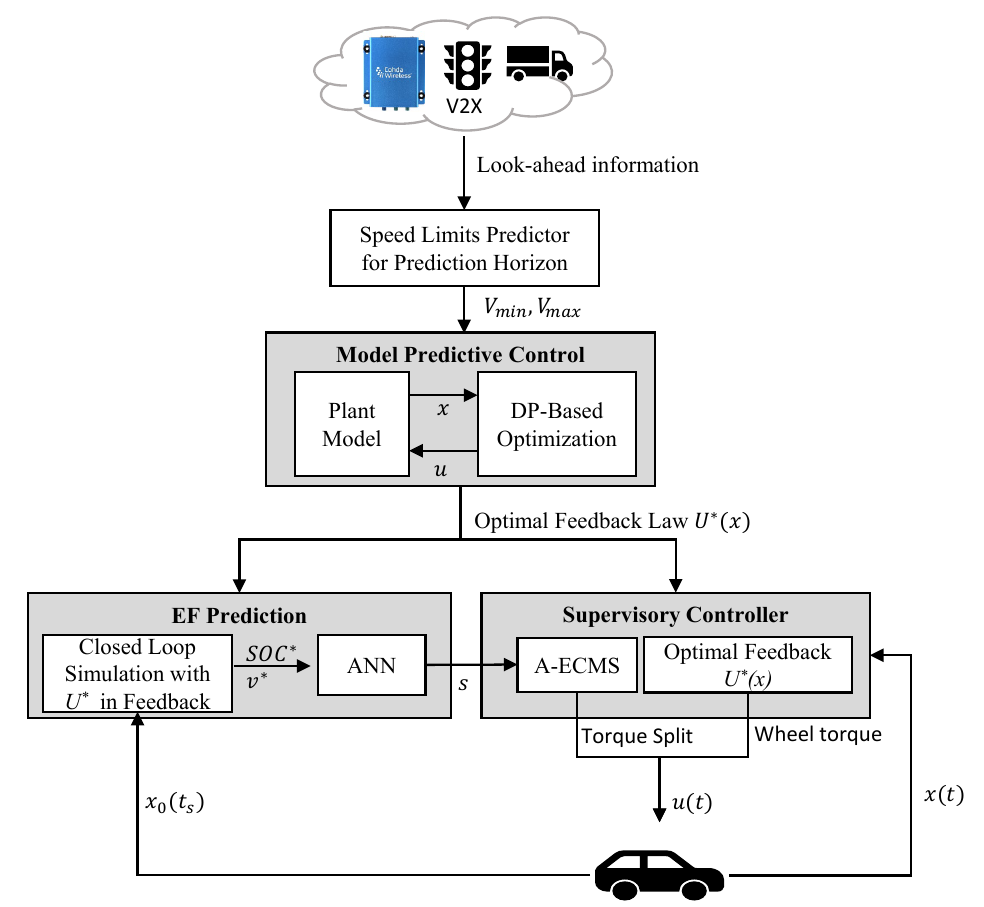
Figure 1. Proposed EMS